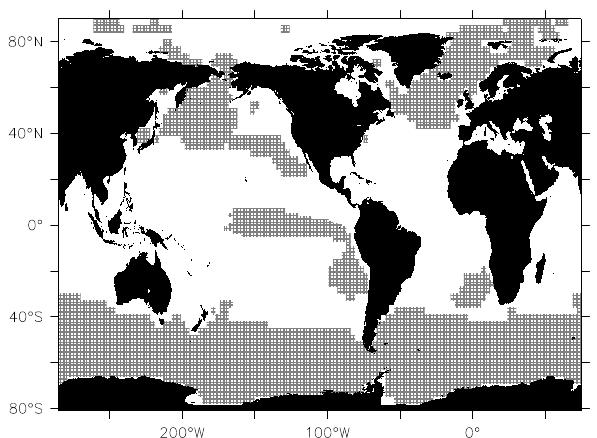
Fig. A1. Diagnosed iron mask (averaged over 150 model years). Shading denotes areas where phytoplankton growth rates in the IRON and DOM simulations are reduced locally such that, simu- lated surface PO − 3 concentrations do not exceed observed PO − 3 4 monthly mean concentrations from the World Ocean Atlas (WOA) (Conkright et al.,